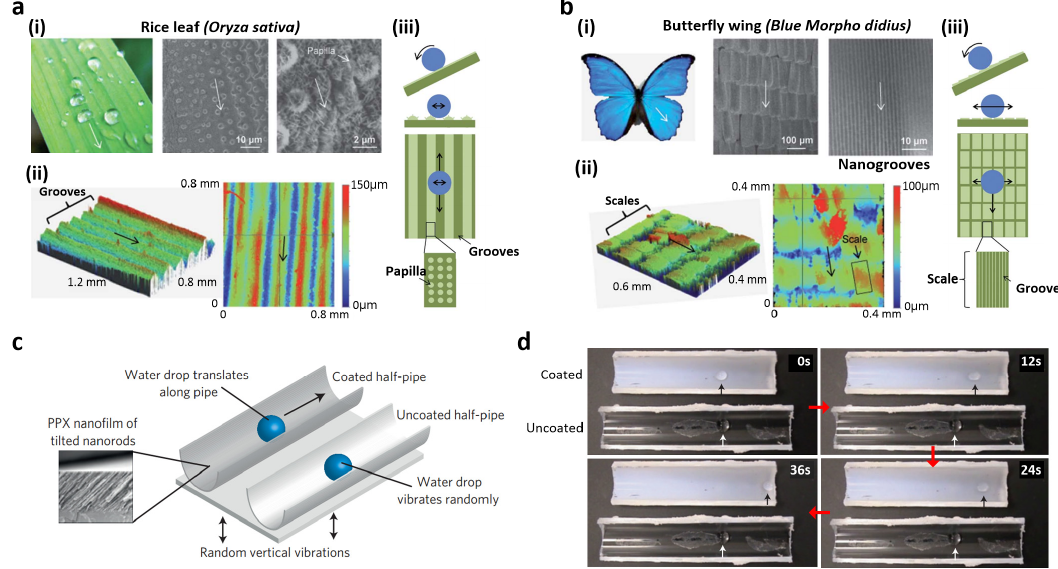
Figure 4. ( a ) Bidirectional anisotropic wetting of a rice leaf ( Oryza sativa ): ( i ) Photograph and SEM images of the rice leaf; ( ii ) Optical profiler height map of the rice leaf; ( iii ) Bidirectional anisotropic wetting behavior; ( b ) Unidirectional wetting behavior of a butterfly wing ( Blue Morpho didius ): ( i ) Photograph and SEM images of the Blue Morpho didius butterfly wing; ( ii ) optical profiler height map of the butterfly wing; and ( iii ) unidirectional anisotropic wetting behavior; ( c ) Droplet motion on poly(p-xylylene) film of tilted nanorods; and ( d ) corresponding time-lapse frames of droplet motion. Reproduced from [66,67] with the permission by Royal Society of Chemistry, Copyright 2012 and by Nature Publishing Group, Copyright 2010.